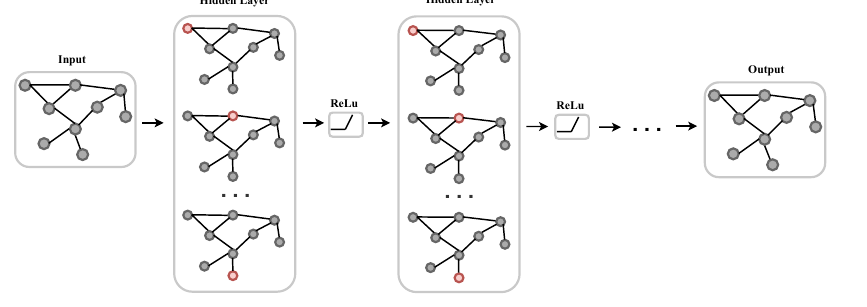
Figure 2. Graph convolutional